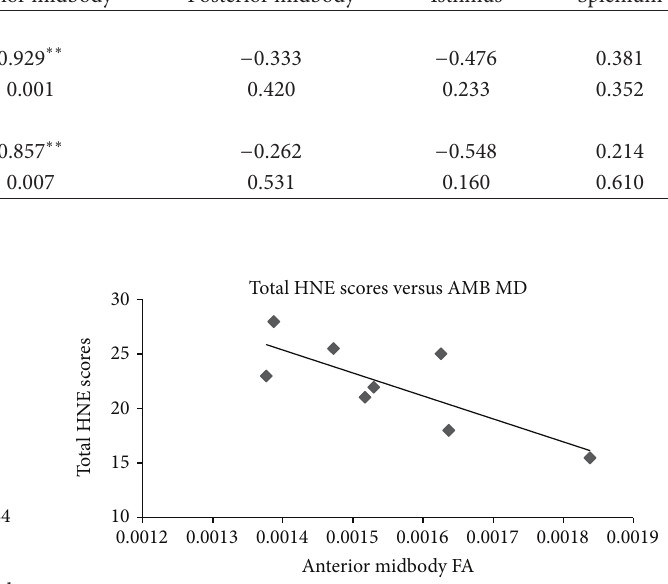
F 3: Scatterplot of total HNE scores versus anterior